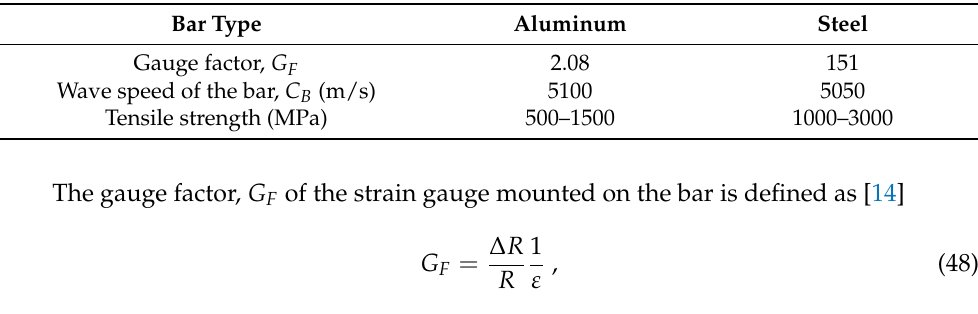
Table 3. Properties and specification of the aluminum and steel